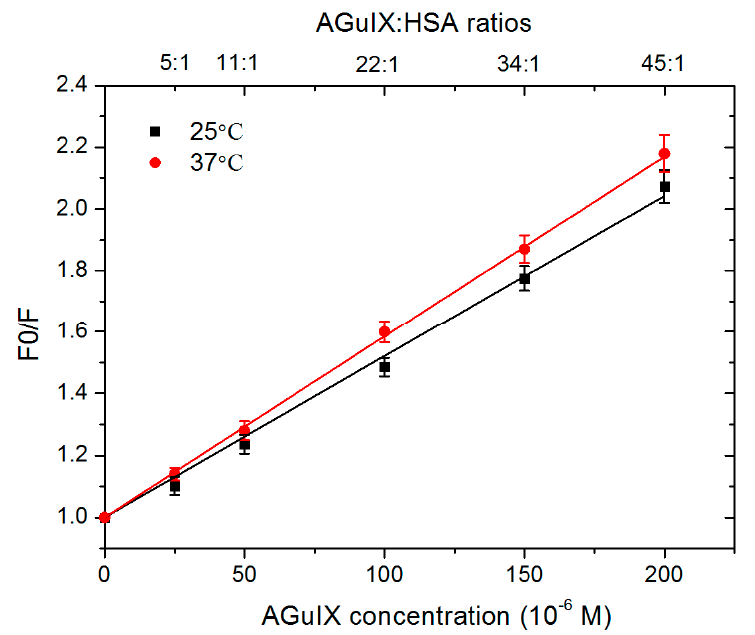
Figure 7. Stern–Volmer plots (F 0 /F) obtained at 25 °C (black) and 37 °C (red) as function of AGuIX ® :HSA ratios, from 5:1 to 45:1.